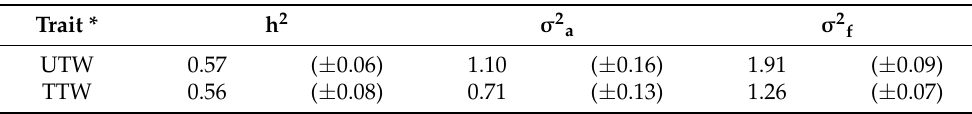
Table 2. Estimates of heritability (h 2 ), additive genetic variance ( σ 2 a ) and phenotypic variance ( σ 2 f ). Standard errors are reported in